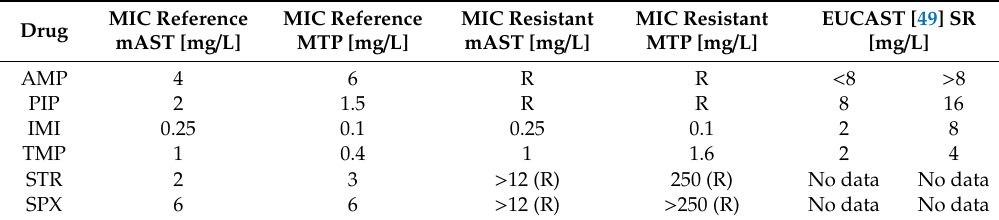
Table 1. MIC values for the two tested strains measured in the mAST device and via standard microdilution in microtiter plate (MTP) and compared to EUCAST breakpoints for susceptible (S) and resistant (R) strains by color coding: values for are green for susceptibility red for resistance, and grey for no data. Dose–response curves for tested drugs can be found in the ESI.